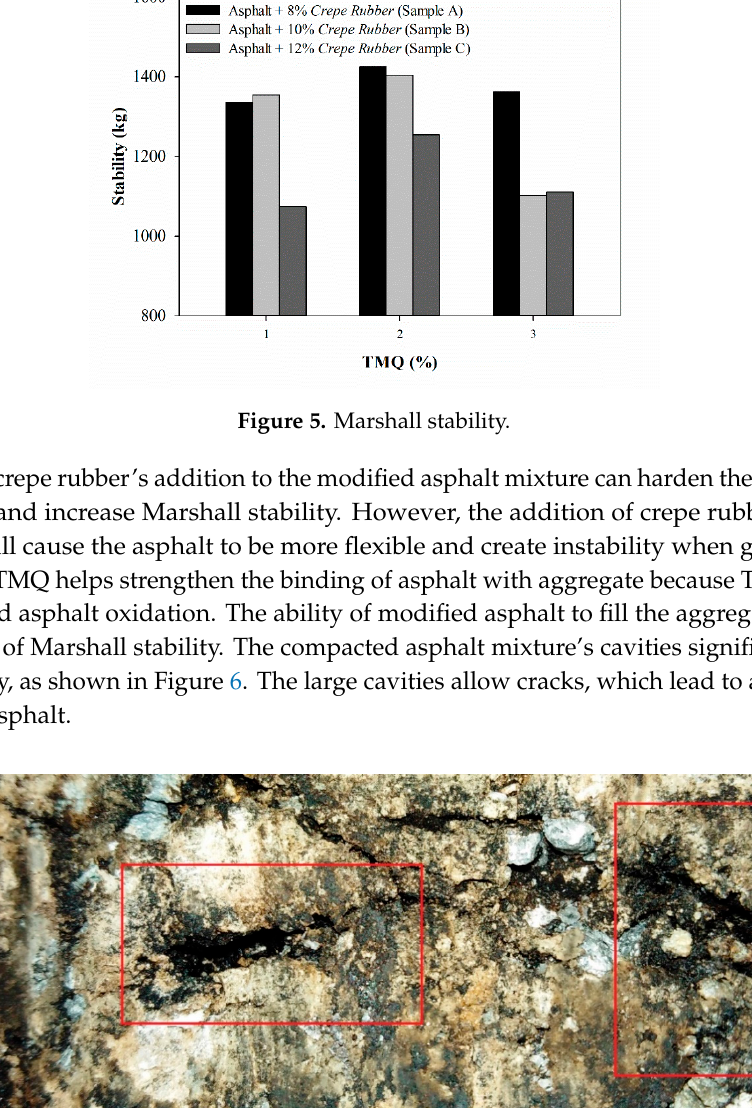
Figure 6. Cavities between aggregates in Marshall specimens.